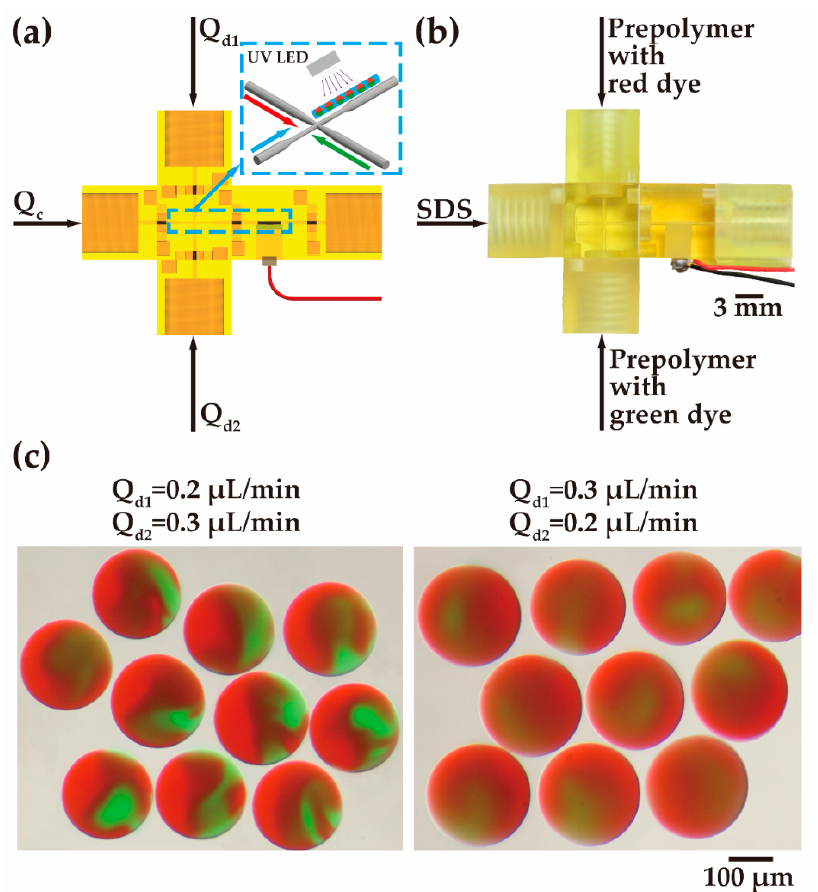
Figure 7. Schematic illustration of Janus particles. ( a ) Schematic drawing and ( b ) the experimental setup of the Janus particle-generation system. ( c ) The generated Janus particles at different flow rates.